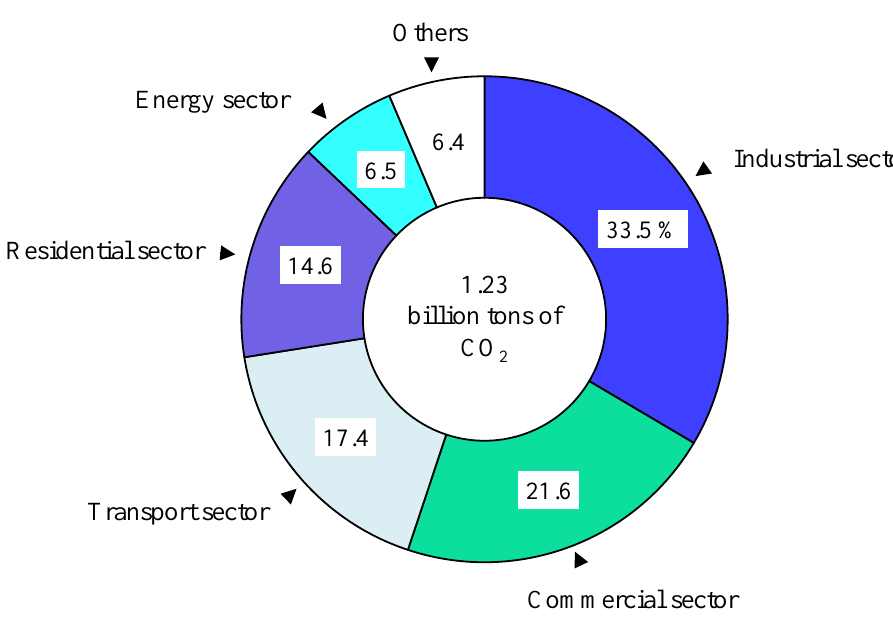
Sources of Carbon Dioxide Emissions 1)